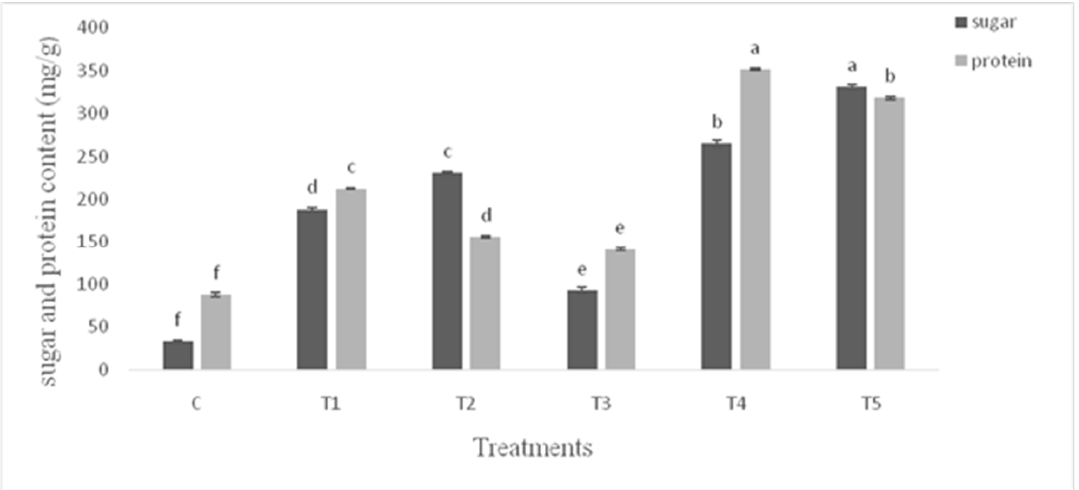
Figure 7. Sugar and protein content (mg/g) of tomato leaves infested with S. litura and under control condition. Data are means of four replicates along with standard error bars. Different letters are indicating significant differences ( p < 0.05) among treatments.